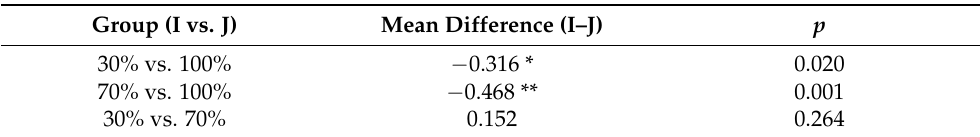
Table 16. Post hoc (LSD) multiple factors comparison analysis of impacts of different edge permeabil- ity levels on perceived anxiety.